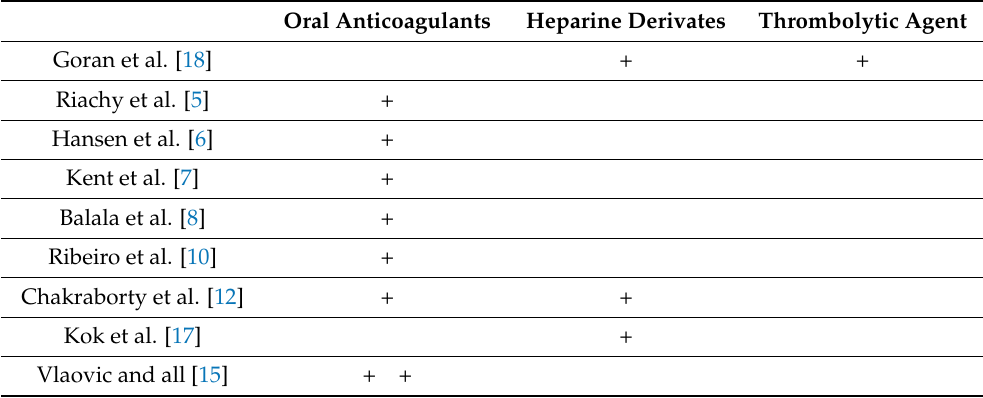
Table 1. Types of anticoagulant treatment associated with spontaneous pulmonary